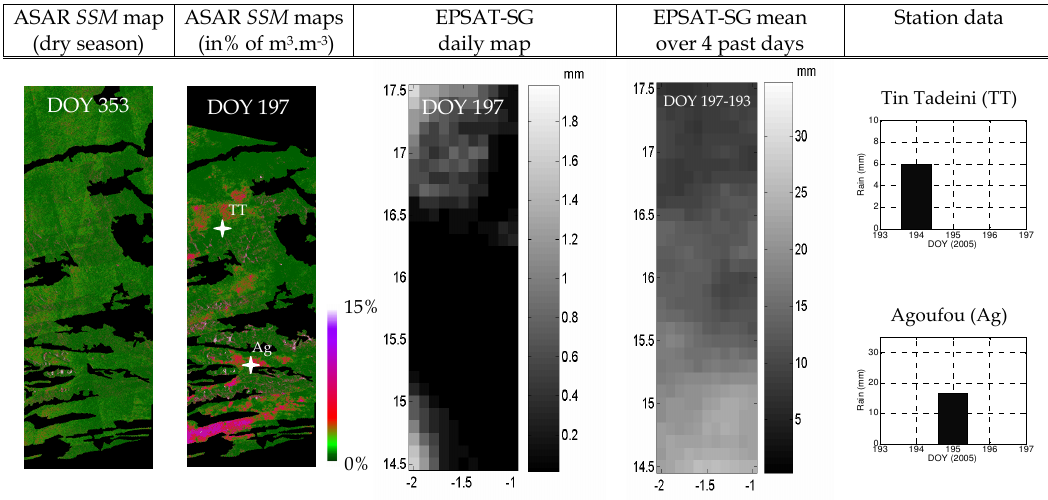
Fig. 8. Soil moisture (SSM) maps established during the 2005 dry (December, 19) and wet (July, 16) seasons compared to EPSAT-SG rainfalls estimates on the same day and over the four previous days and with rainfall recorded at Agoufou and Tin Tadeini during the five same days.